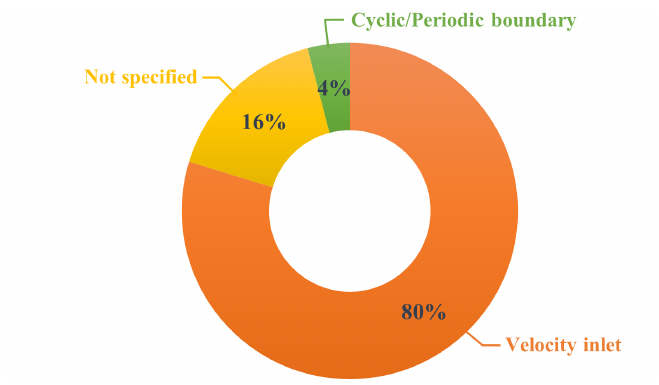
Figure 17. Inflow boundary type.